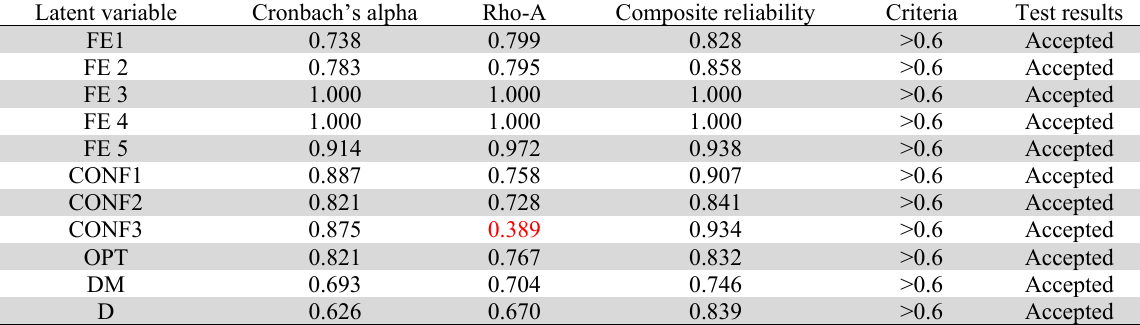
Table A8 Summary of Statistical Tests: Cronbach’s Alpha and Composite Reliability (Model